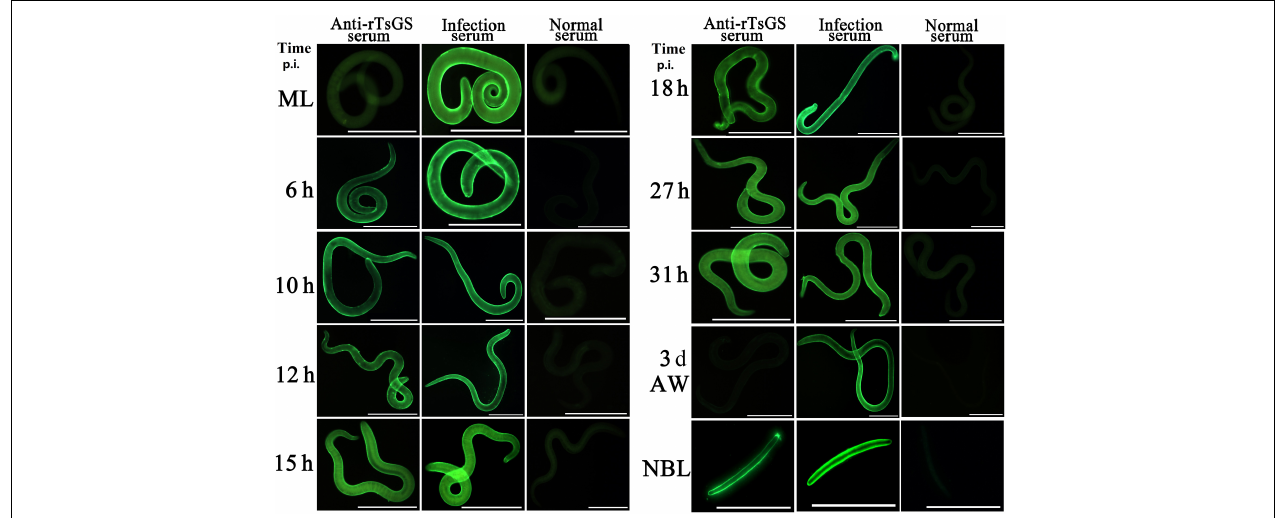
FIGURE 5 | Expression of TsGS on the surface of various Trichinella spiralis stages by IIFA with anti-rTsGS serum. The IIFA was performed with whole intact worms of different T. spiralis stages [muscle larvae (ML), 6–31-h intestinal infectious larvae (IIL), adult worms (AW), and newborn larvae (NBL)]. The worms were blocked with 5% normal goat serum at 37 ◦ C for 2 h and then probed at 37 ◦ C for 2 h with 1:10 diluted diverse sera (anti-rTsGS serum, infection serum, and normal serum). After washes with phosphate-buffered saline, the worms were stained using 1:100 dilutions of goat anti-mouse IgG-FITC conjugate and examined under fluorescence microscopy. Intense fluorescence staining was observed on the epidermis of IIL, AW, and NBL by using anti-rTsGS serum, but not at ML and AW stages. The worms recognized by infection serum served as a positive control and normal serum as the negative control. Scale bars = 100 µ m.